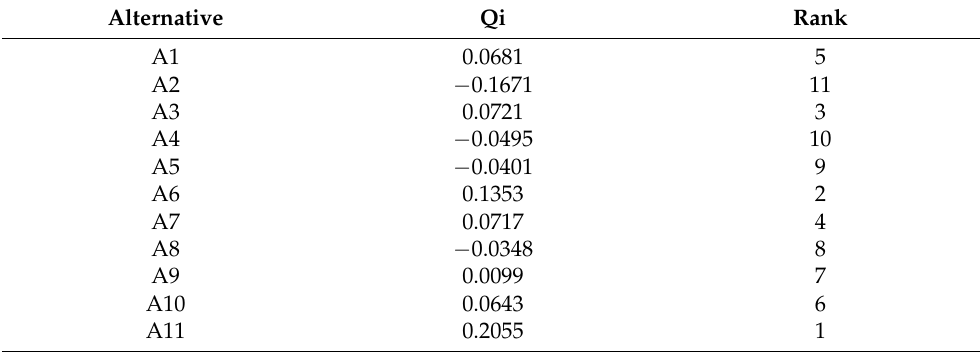
Table 8. Alternative ranking